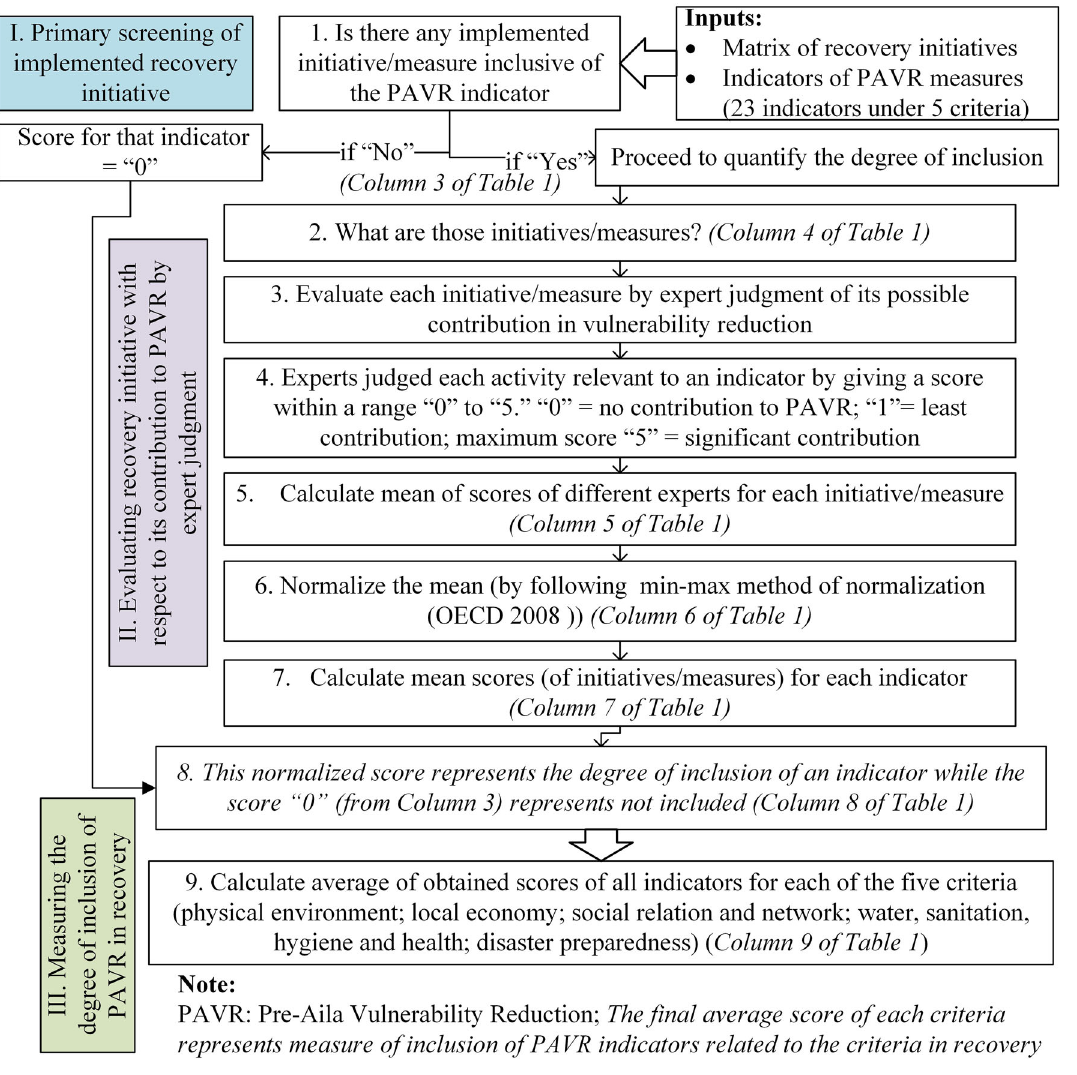
Fig. 3 The diagnostic analysis process to examine inclusion of PAVR in Cyclone Aila